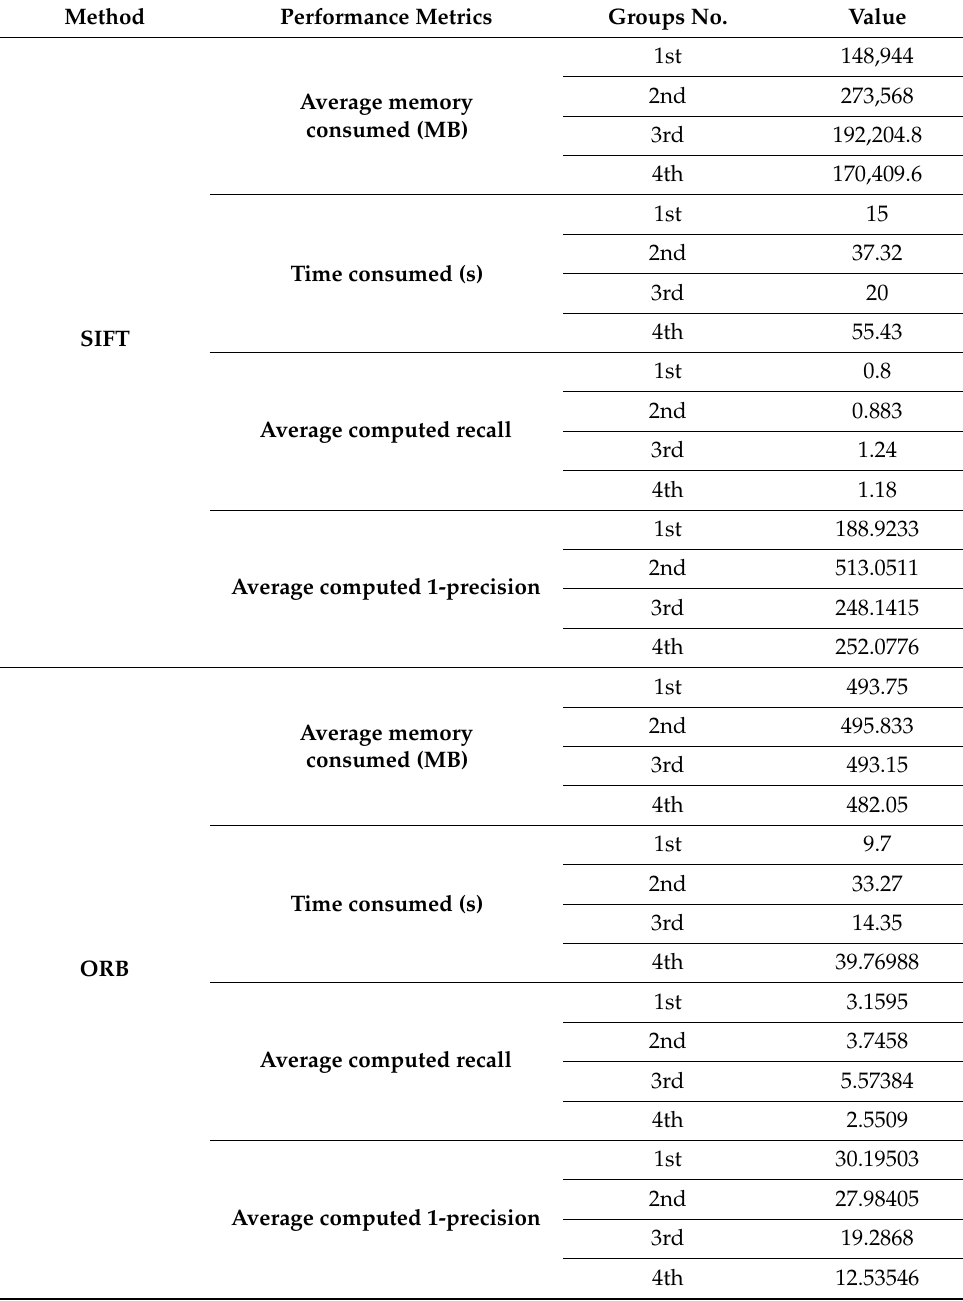
Table 1. Computed performance metrics for handcrafted features over the four groups of the ImageNet-Sketch dataset. Method Performance Metrics Groups No.